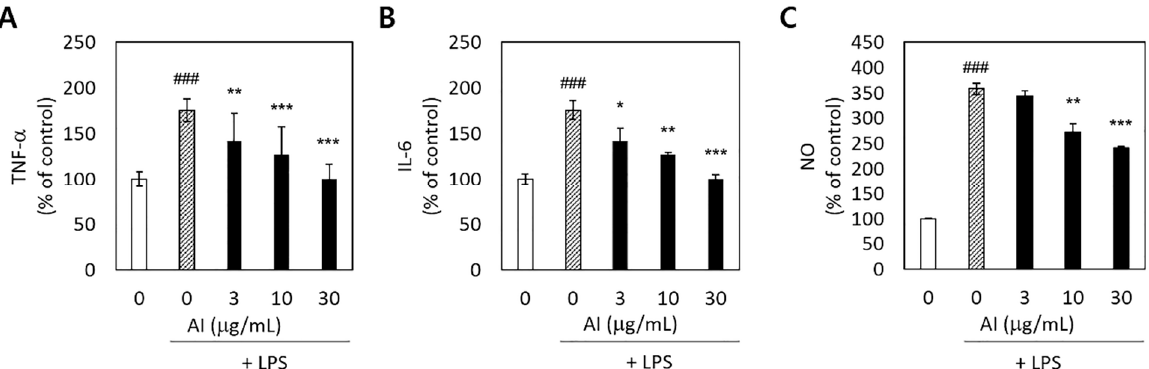
Figure 3. Inhibitory effects of Asplenium incisum (AI) on tumor necrosis factor- α (TNF- α ) ( A ), interleukin-6 (IL-6) ( B ), and